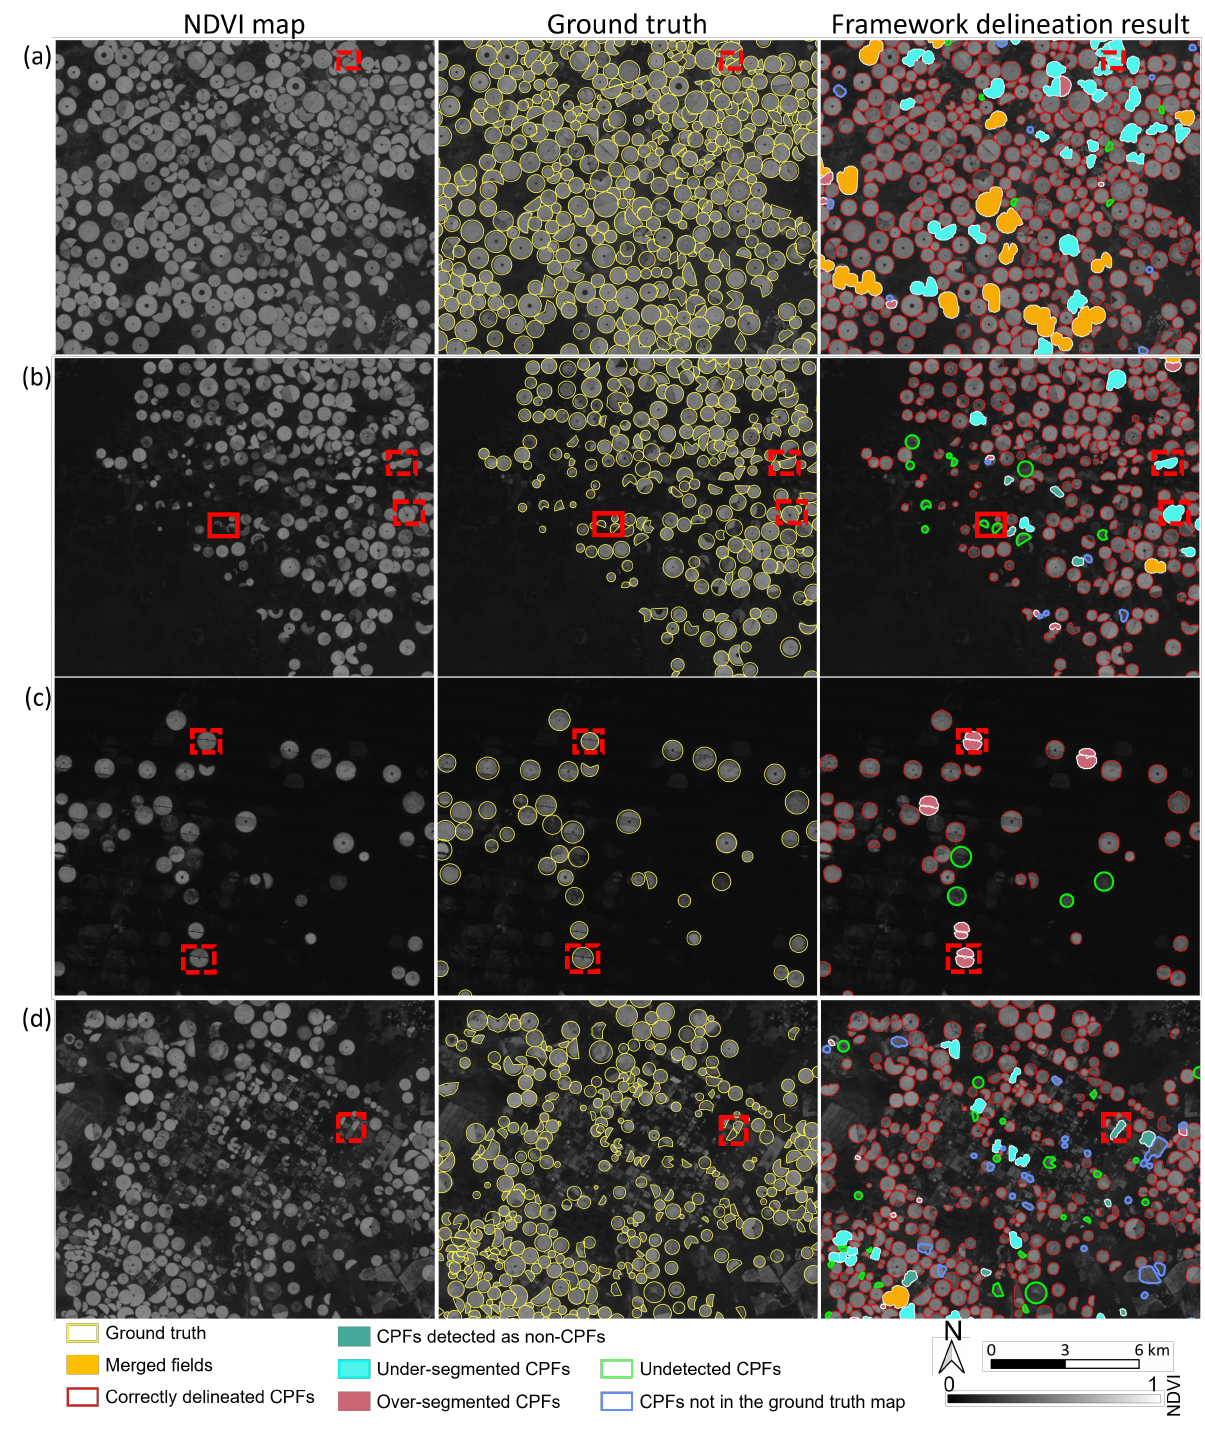
Figure 6. Examples of field delineation errors. The dashed red rectangles in ( a , b ) show center- pivot fields (CPFs) merged together and being under-segmented. The solid red rectangle in ( b ) shows CPFs not present on the delineated-map. The dashed red rectangles in ( c , d ) show CPFs being over-segmented and CPFs being detected as non-CPFs (i.e., fields showing rectangle shapes),